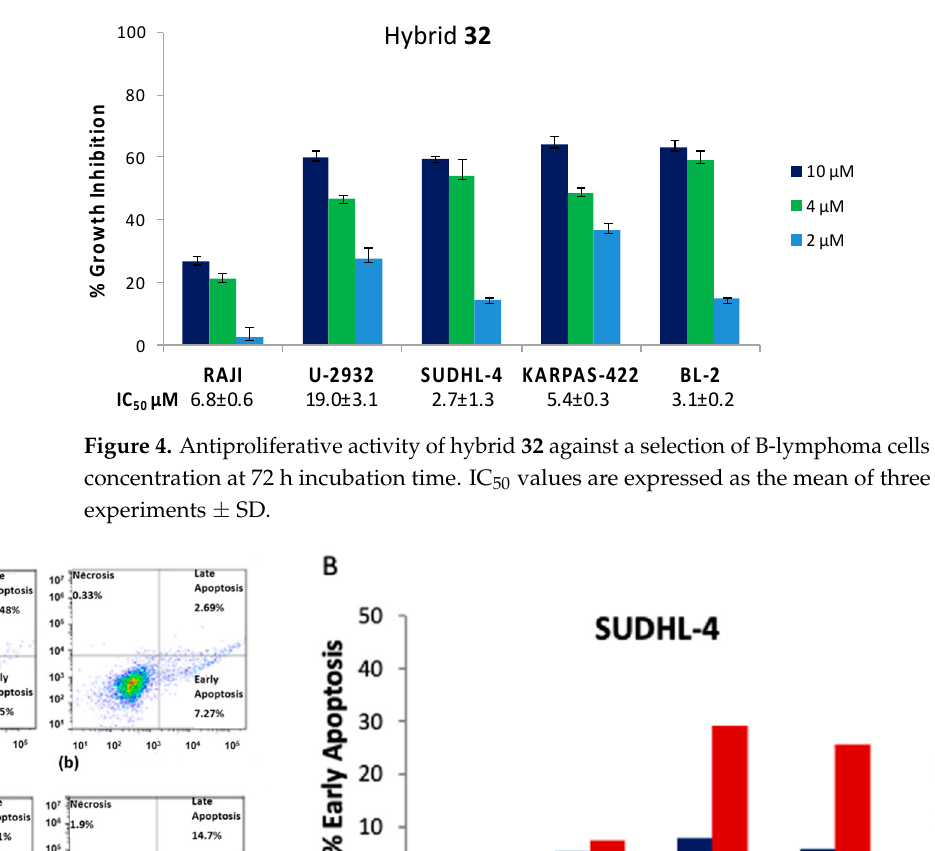
9 of 20 Scheme 3. ( A ) Synthesis of BA-DHA hybrids trough condensation reaction. Reaction conditions: (a) EDCI, DMAP, DMF, 25 °C, 18 h, 25–60% yield; ( B ) Synthesis of UDC-DHA hybrid 41 via click chemistry. Reaction conditions: (b) propargyl-DHA/N 3 UDCMe ratio: 1/1, CuI 0.1 eq, room temper- ature, 18 h, 28% yield. Hybrid 32 (CDC based) was preliminarily tested in vitro against a selection of Diffuse Large B Cell Lymphoma (DLBCL) such as RAJI, U2932, SUDHL-4, KARPAS-422 and BL- 2. Lymphoma is the most common blood cancer that can affect both T lymphocytes (T- cells) and B lymphocytes (B-cells). T-cell non-Hodgkin lymphomas are relatively uncom- mon, accounting for around 15% of all lymphomas, but are associated with a poor clinical outcome [40]. DLBCL is one of the most common types of aggressive B-cell non-Hodgkin lymphoma that can grow in lymph nodes as well as outside of the lymphatic system, in- filtrating tissues and obstructing organs. The large number of patients who are refractory to treatments or relapse afterwards strongly encourages the development of new anti- cancer drugs [41].